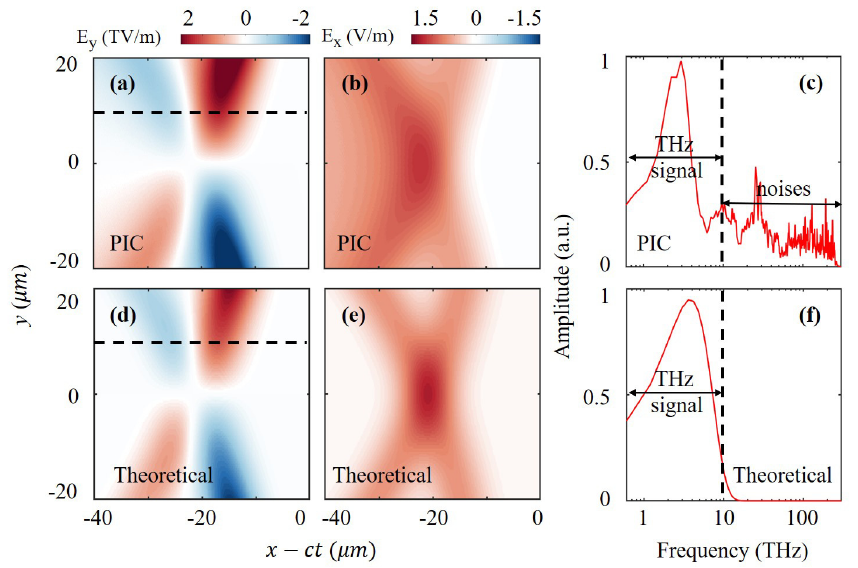
Figure 2. Distribution of ( a ) the transverse electrical field E y and ( b ) longitudinal electrical field E x in the x-y plane from the 3D-PIC simulations. ( c ) Fast Fourier transform (FFT) signal of the E y field along the dotted line in ( a ). Distribution of ( d ) the transverse electrical field E y and ( e ) longitudinal electrical field E x distribution from the theoretical calculation in the x-y plane. ( f ) FFT signal of the E y field along the dotted line in ( d